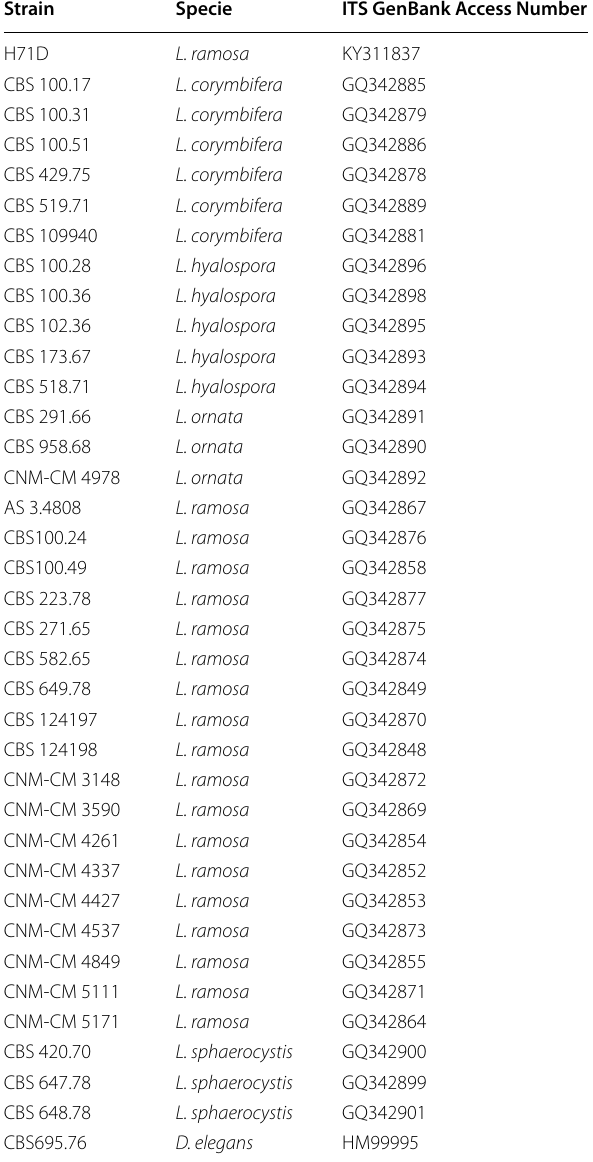
Table 1 GenBank accession numbers of the DNA sequences from members of the genus Lichteimia used in this